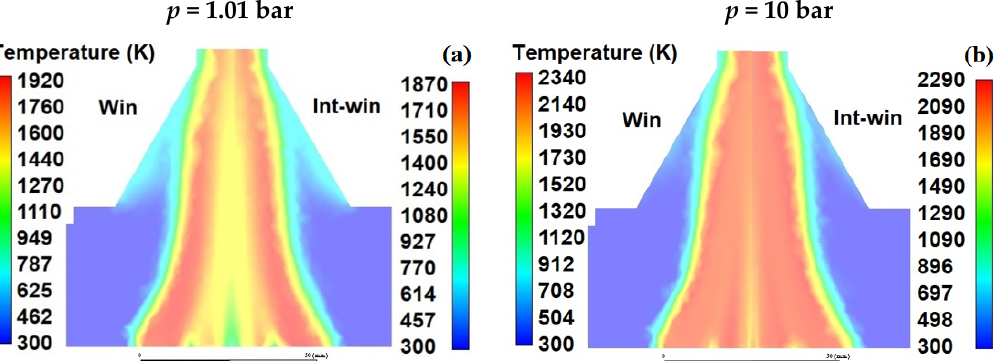
Figure 3. Temperature cross-sectional distributions (K) along window (Win) and inter-window (Int-win) axes of burner of premixed flame C 2 H 4 /air ϕ = 1.77 at atmospheric pressure ( a ) and 10 bar ( b ).